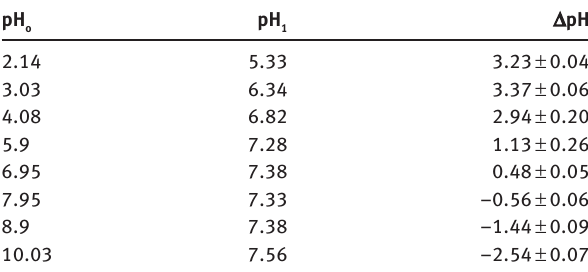
), final pH (pH ), and ∆pH values of water o 1